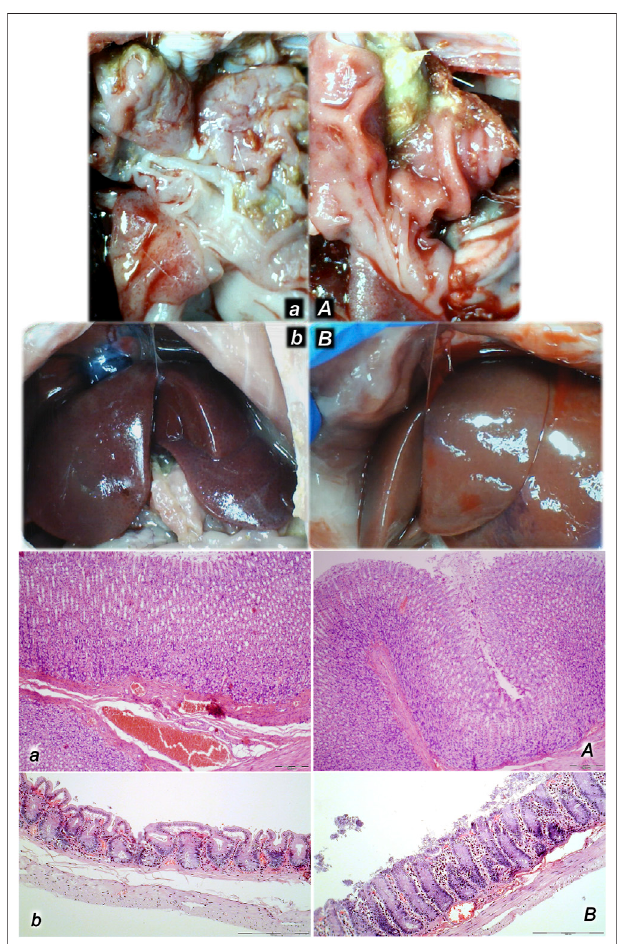
FIGURE 9 | Illustrative presentation of gross and microscopic presentation. Gross presentation. Stomach (a, A) and liver (b,B) (white letters) after the increased intraabdominal pressure and medication (sc) (saline (5 ml/kg, left, stomach and duodenum with multiple small hemorrhagic lesions (a), and congested liver (b) presentation) or BPC 157 (10 ng/kg, right, stomach and duodenum, and liver A, B): 25 mmHg (30 min) (a, A), and 40 mmHg (30 min) (b, B). The camera attached to a VMS-004 Discovery Deluxe USB microscope (Veho, United States). Microscopy presentation. Stomach (a, A) and colon (b, B) (black letters) presentation in rats with the increased intra-abdominal pressure at 50 mmHg for 25 min treated at 10 min increased intra-abdominal pressure time with saline (control, a, b) or BPC 157 (A, B). The control group showed marked hyperemia and congestion of the stomach wall (a) and a reduction of the colonic crypts with focal denudation of the super fi cial epithelia (b). BPC 157-treated rats exhibit presentation close to normalgastrointestinaltractpresentation(A,B).(HE;a,A,magni fi cation ×